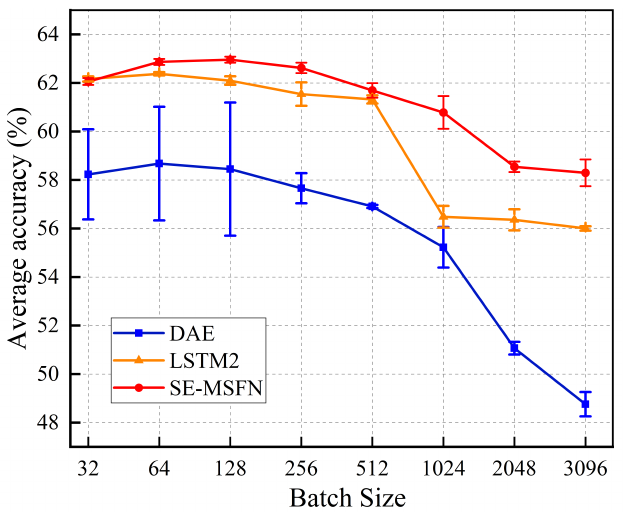
Figure 3. Performance of the baseline model for recognition on the 2016A dataset at various batch